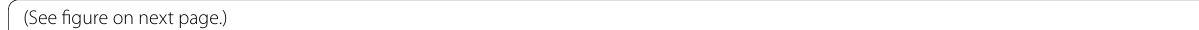
figure on next Fig. 2 62‑year‑old male presented to stroke unit with left‑sided weakness of 6‑h duration. a DWI reveals true diffusion restriction seen involving the M4 & M5 segments along the territory of MCA with low ADC representing ASPECT score 8. b CTP revealed significant delay in mean transient time along the left fronto tempro parietal region (white arrows) along M1 to M6 with involvement of deep nuclei as well as internal capsule compared to right cerebral hemisphere with ASPECT score 3. c SWI of the same patient reveals asymmetrical vessel sign with prominent dark dilated veins on the left cerebral hemisphere along M1, 2, 4, 5 & M6 segments; however, the deep nuclei are not affected representing ASPECT score 5. The blooming along the affected vessels denotes hemorrhagic transformation (white arrows).The ASPECT score of SWI and perfusion images are lower than that of DWI representing ASPECT score (5, 3 & 8, respectively). DW/P mismatch noted denoting an area of risk to infarction (penumbra). DW/SWI mismatch is also noted similar to perfusion